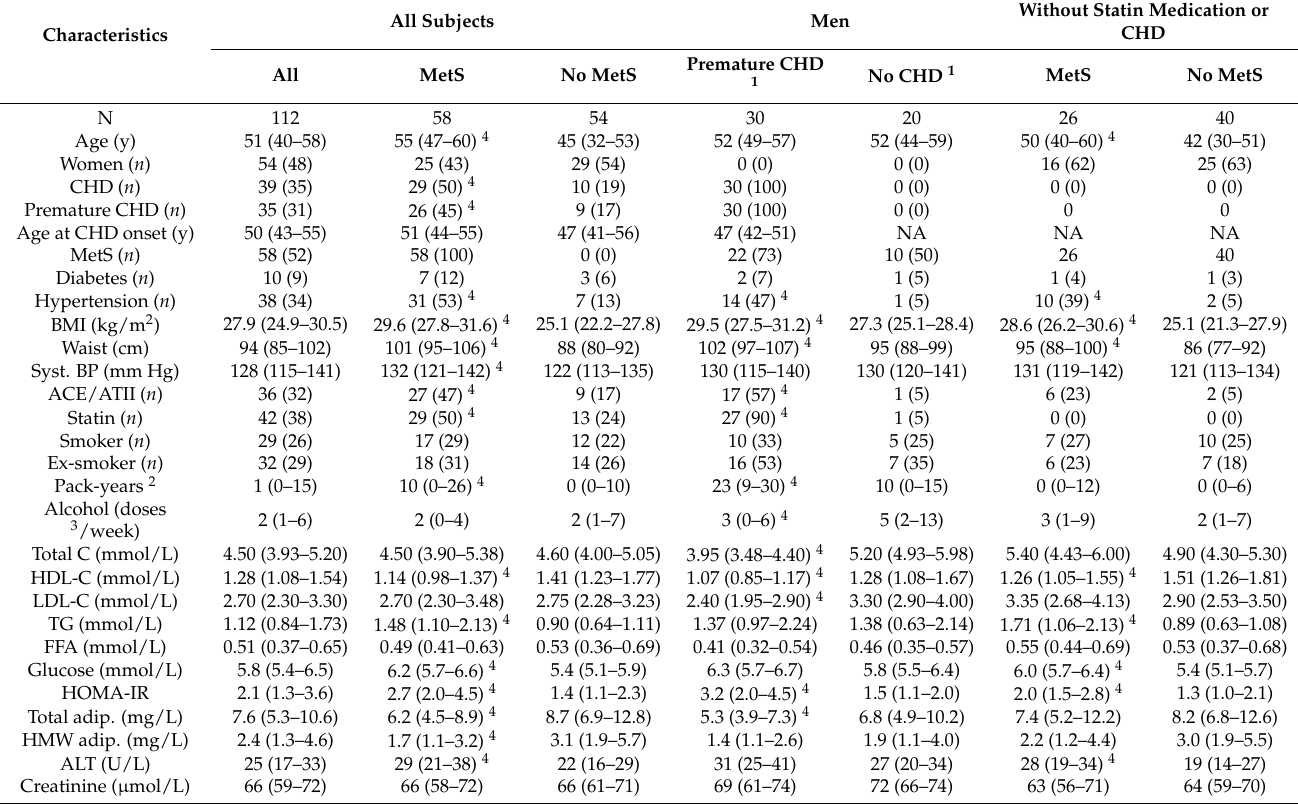
Table 1. Clinical characteristics and biochemical parameters of study